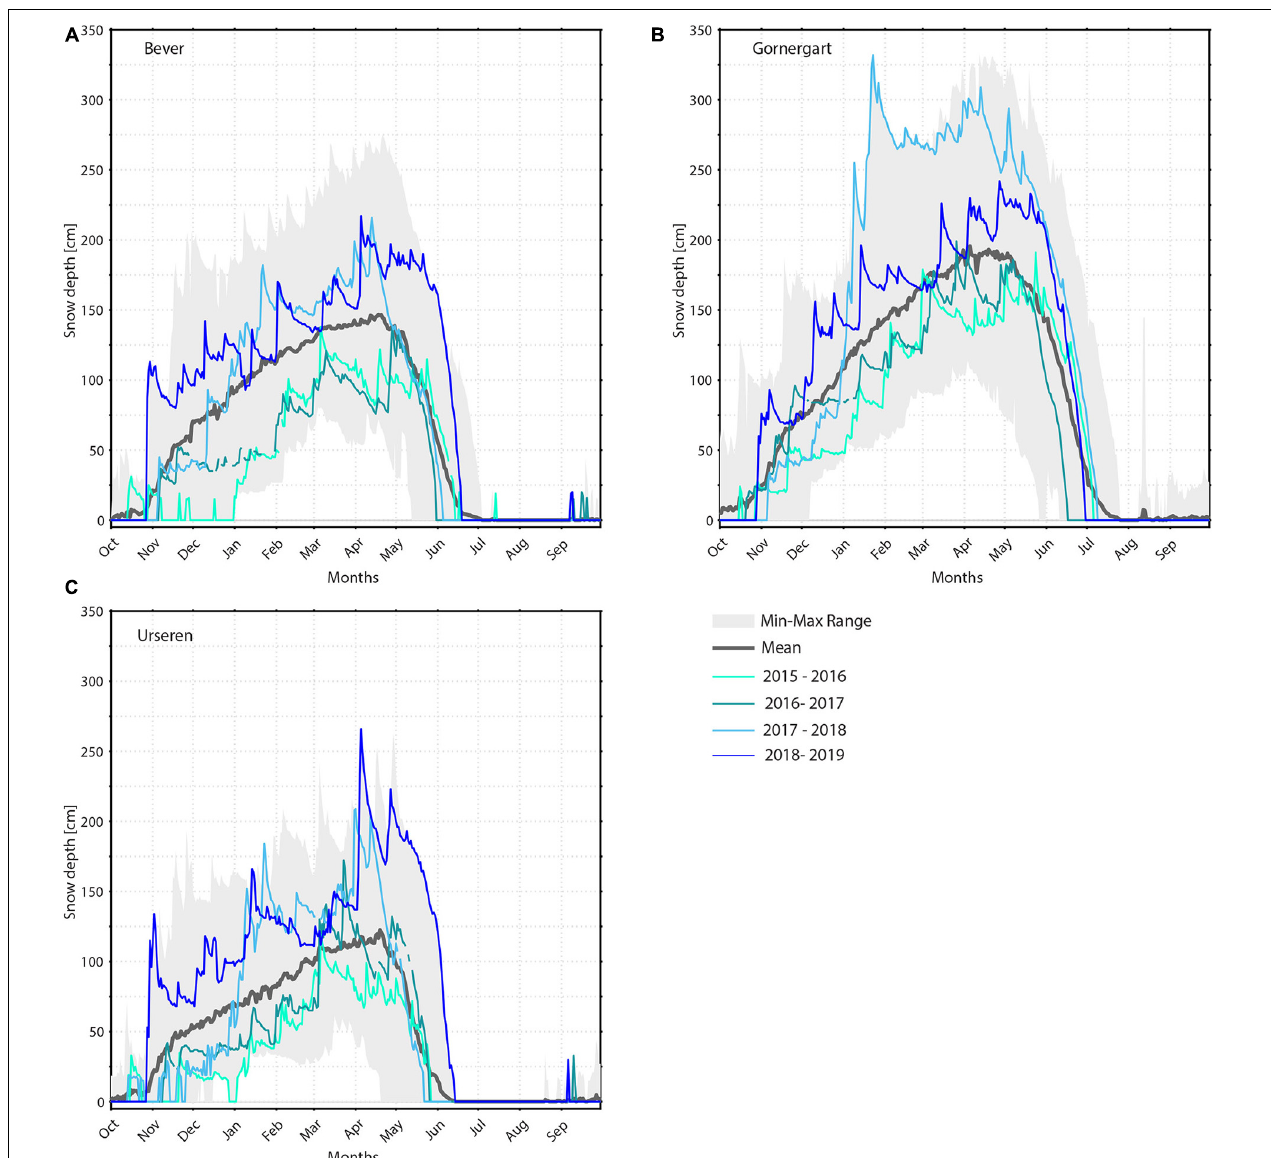
FIGURE 5 | Snow depth at three IMIS stations during the four winter seasons 2016–2019 with both snow-poor and snow-rich conditions: (A) Bever (Engadine), (B) Gornergrat (Upper Valais), and (C) Urseren (Uri Alps). The grey thick line is the mean snow depth and the grey shaded area the minimum and maximum range (Min–Max Range) for the entire observation period 1997–2019. Data is shown for the hydrological